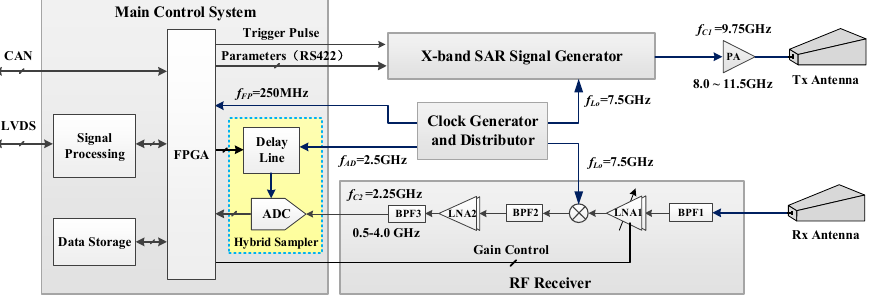
Figure 2. Diagram of the X-band SAR with the non-uniform hybrid.